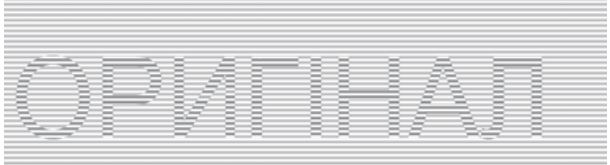
Figure 4. Hidden inscription "ОРИГІНАЛ" formed by the displacement of raster lines in the first field.